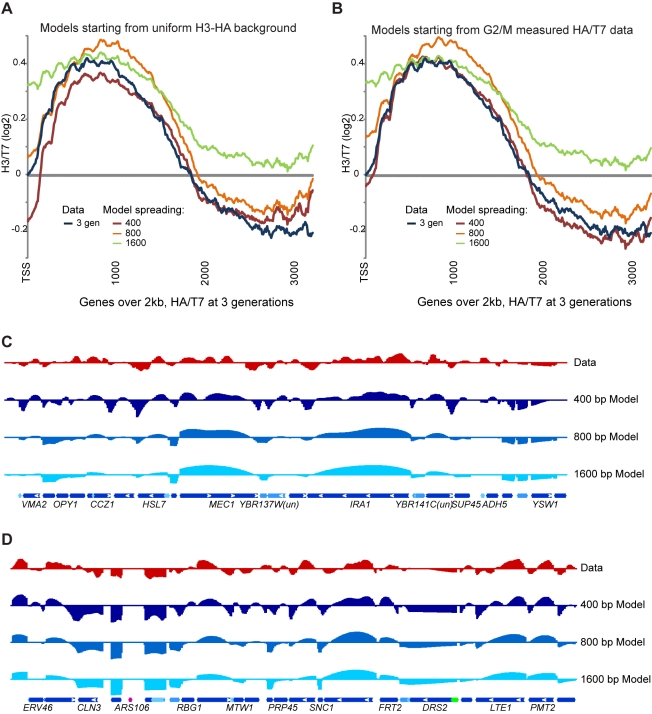
Dependency of histone dynamics model on spreading parameter.(A–B) Parameters in the quantitative model described in Figure 5 were
re-optimized after fixing the spreading term to 400 bp (as in Figure 5), 800, or
1,600 bp. Data and simulations are shown averaged for genes over 2 kb
for models starting with a uniform H3-HA distribution (A) or starting
with the experimentally measured G2/M HA/T7 distribution (B).
(C–D) Examples of data and three models with different spreading
parameters. Genomic coordinates are chromosome 2 490–540 kb (C),
and chromosome 1 60–110 kb (D). Y-axis shows
measured (Data) or predicted HA/T7 values, in Log2.